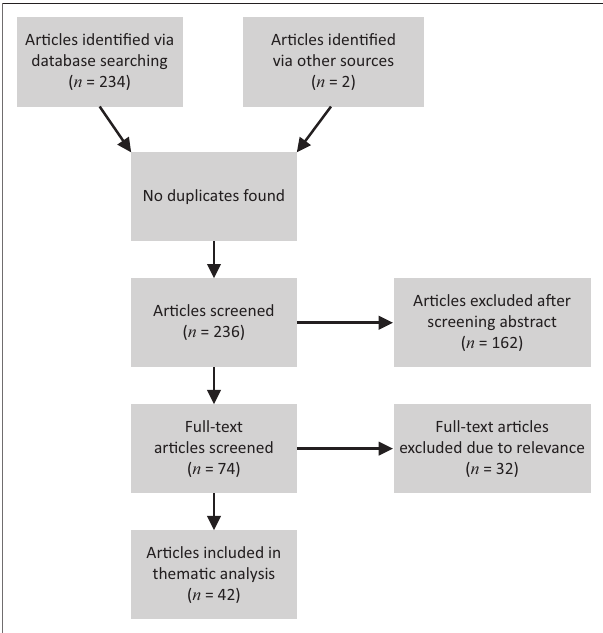
FIGURE 1: Preferred Reporting Items for Systematic Reviews and Meta-Analyses diagram illustrating the search process.